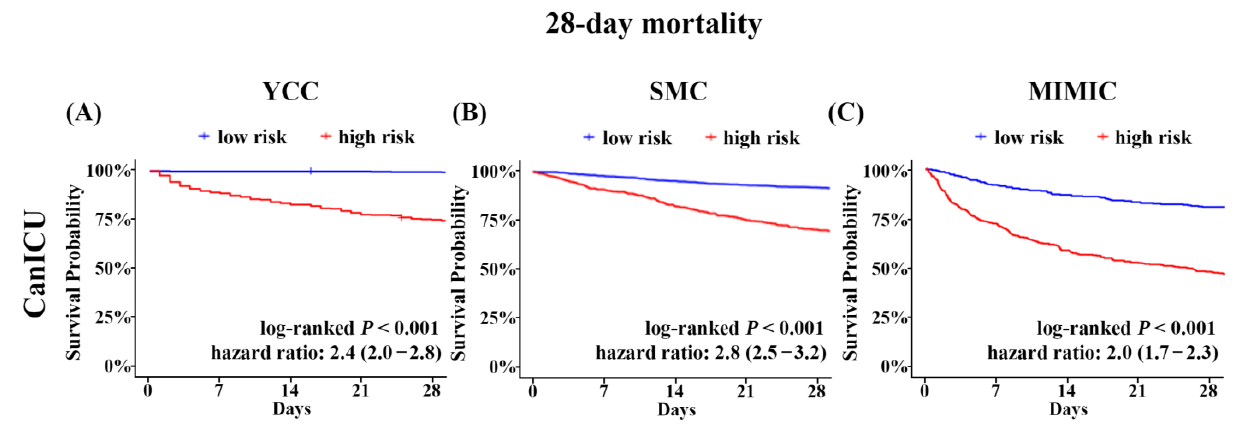
Figure 4. Kaplan-Meier curves according to predicted mortality by the CanICU model in each co- hort. ( A ) 28-day survival probability of YCC validation cohort ( n = 1072). ( B ) 28-day survival prob- ability of SMC cohort ( n = 2563). ( C ) 28-day survival probability of MIMIC-III cohort ( n = 766). YCC, Yonsei Cancer Center; SMC, Samsung Medical Center; MIMIC, Medical Information Mart for Inten- sive Care.